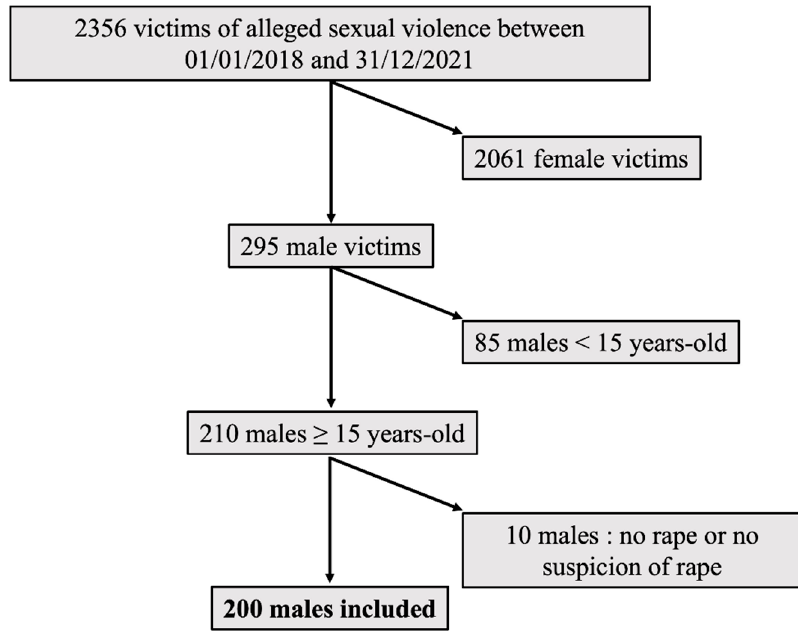
Figure 1. Flow chart of inclusion.